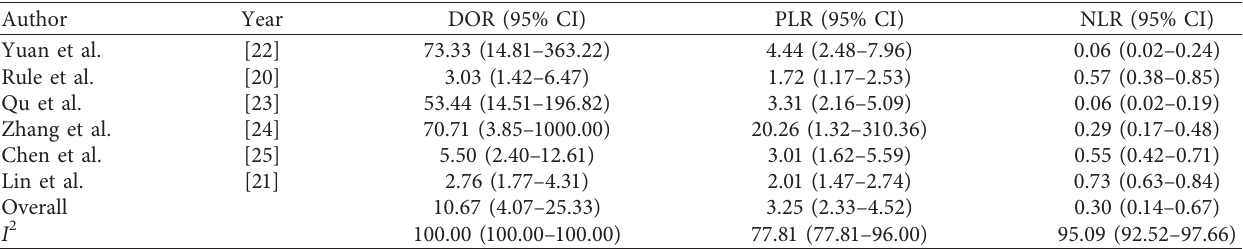
Figure 2: Forest plot of estimates of sensitivity and specificity for procalcitonin assays in the diagnosis of bacterial infection in liver failure patients. The point estimates of sensitivity and specificity from each study are shown as solid circles. Error bars indicate 95% CIs. CI � confidence interval. Table 2: Meta-analysis results derived from the 2 × 2 tables of individual studies using serum procalcitonin as a marker for bacterial infection in liver failure